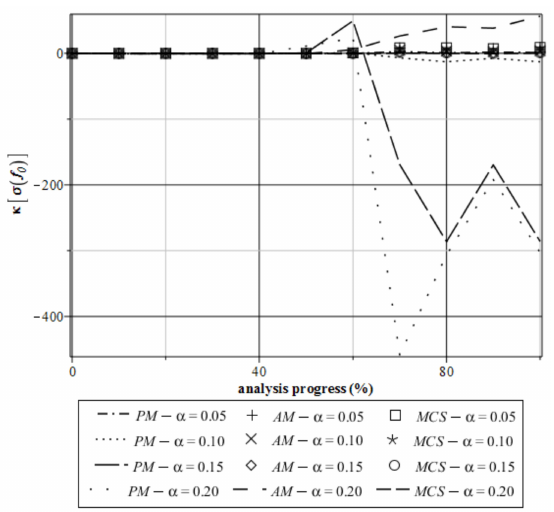
Figure 14. Kurtosis of the extreme von Mises stress E[ σ (f 0 )] for the